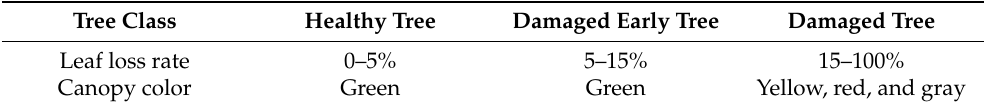
Table 1. Sample tree evaluation table. Tree Class Healthy Tree Damaged Early Tree Damaged Tree Leaf loss rate 0–5% 5–15% 15–100% Canopy color Green Green Yellow, red, and